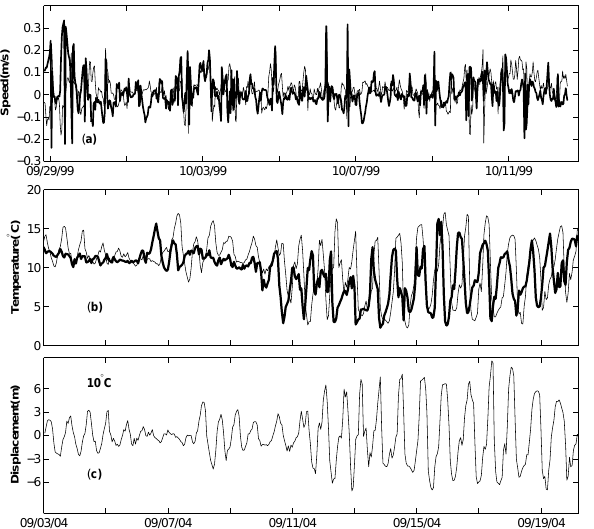
Fig. 2. (a) Time series of the meridional (solid line) and zonal (bold line) components of the current at a depth of 35m smoothed using a Tukey window with a width of 1h in the autumn of 1999. (b) Time series of the temperature variations from the A mooring (bold line) and B mooring (solid line) smoothed using a Tukey window with a width of 1h in September 2004. (c) Time series of the isotherm (10 ◦ C) displacements from the B mooring in September 2004.